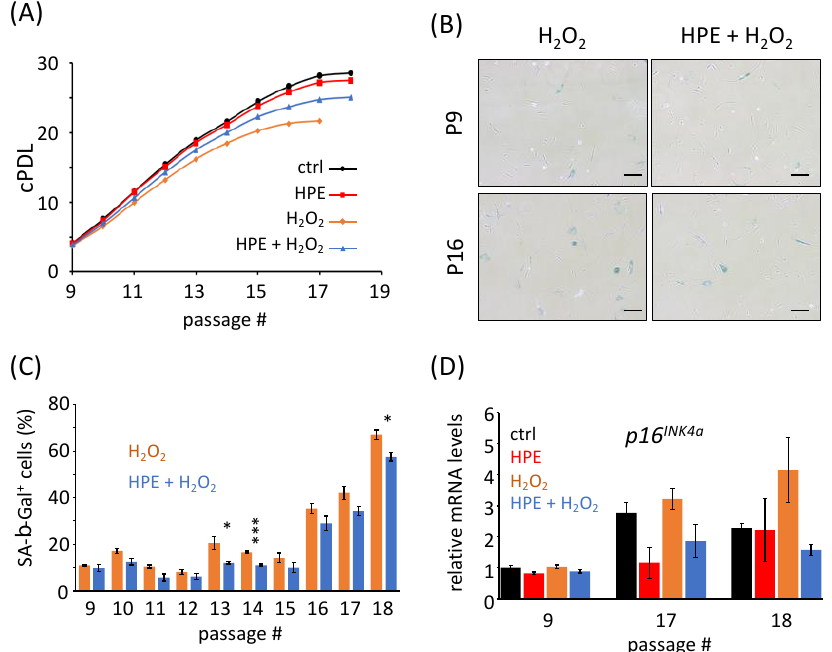
Figure 1. HPE treatment of NHDF cells delays the cellular senescence process. ( A ) Cumulative population doubling level (cPDL) of normal human dermal fibroblasts (NHDFs) with human placental extract (HPE) and/or H 2 O 2 was measured under indicated conditions. Two independent proliferation assays were performed. ( B ) Pictures of senescence-associated β -Galactosidase (SA- β -Gal) -positive cells (blue) at passages 9 (P9) and 16 (P16), under indicated conditions, were taken. Scale bars represent 100 µ m. ( C ) The percentages of SA- β -Gal-positive cells, under indicated conditions, were quantified at different passages. ( D ) p16 INK4a gene expression at different passages, at indicated conditions, was analyzed using qPCR. The expression level under the control (ctrl) condition at P9 was set to 1. * p < 0.05, *** p < 0.001 was compared between H 2 O 2 with HPE, and H 2 O 2 without HPE, within the same passages, by Student’s two-tailed t